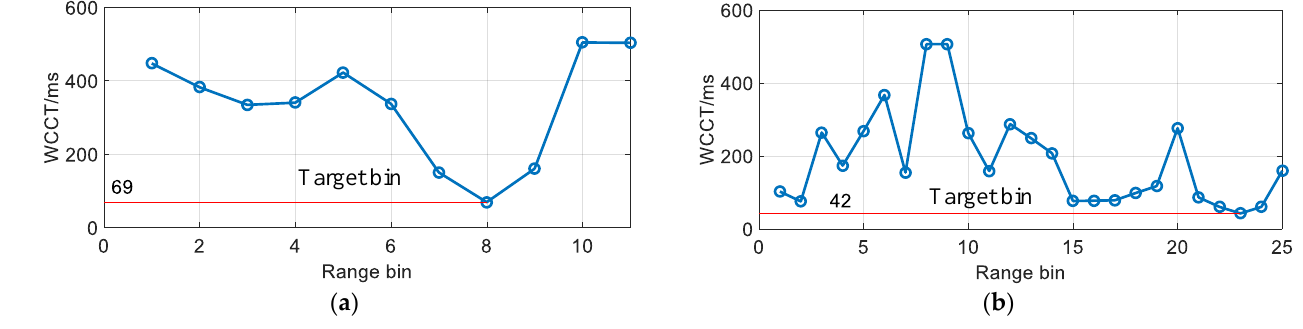
r drops from 1 to 0.5. The j